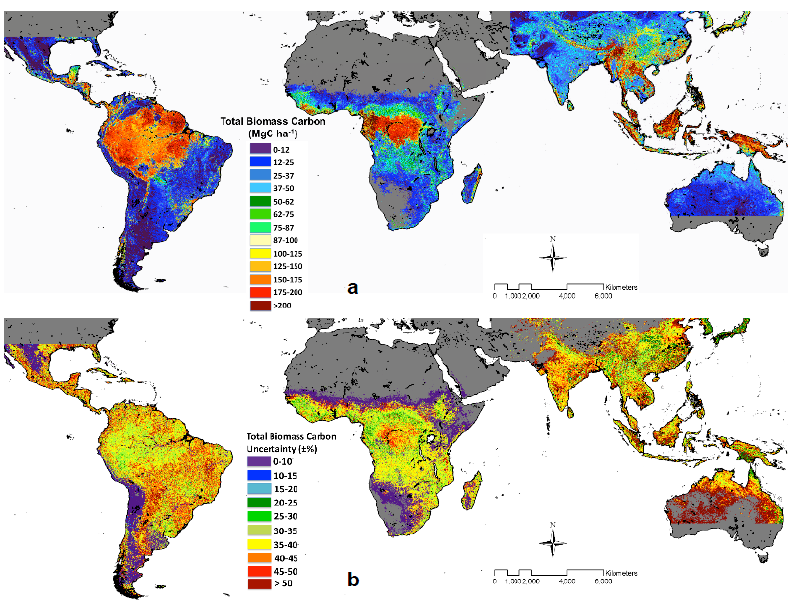
Figure 5. A global map of carbon density of tropical and subtropical forests ( a ) and the geographic distribution of the uncertainty of the estimate ( b ) [165].